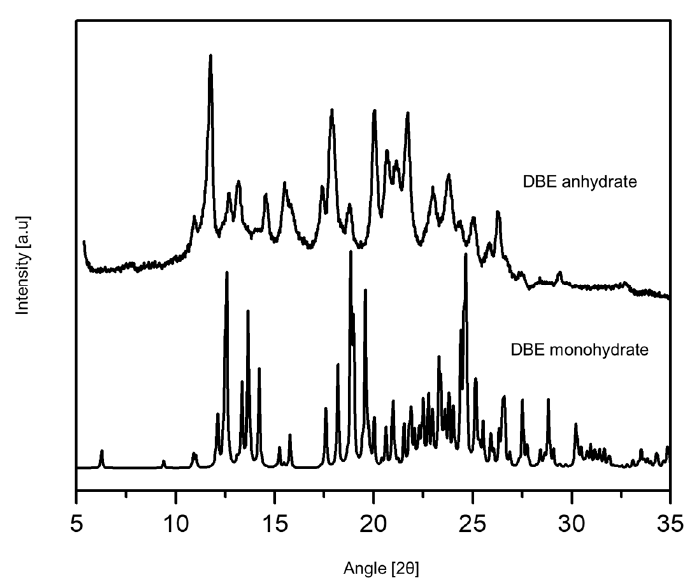
Figure 4. Powder X-ray diffraction (PXRD) pattern of DBE crystal forms.